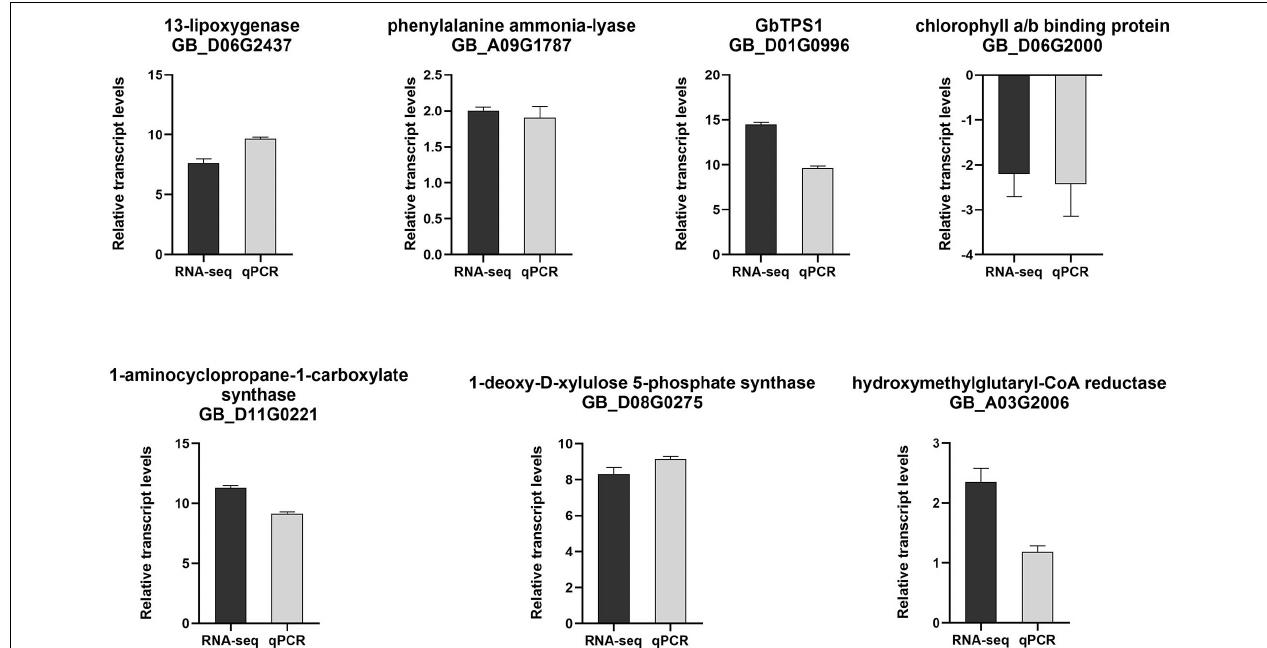
FIGURE 3 | Log 2 (fold change) of selected genes in RNA-seq (black bar) and qPCR (gray bar)